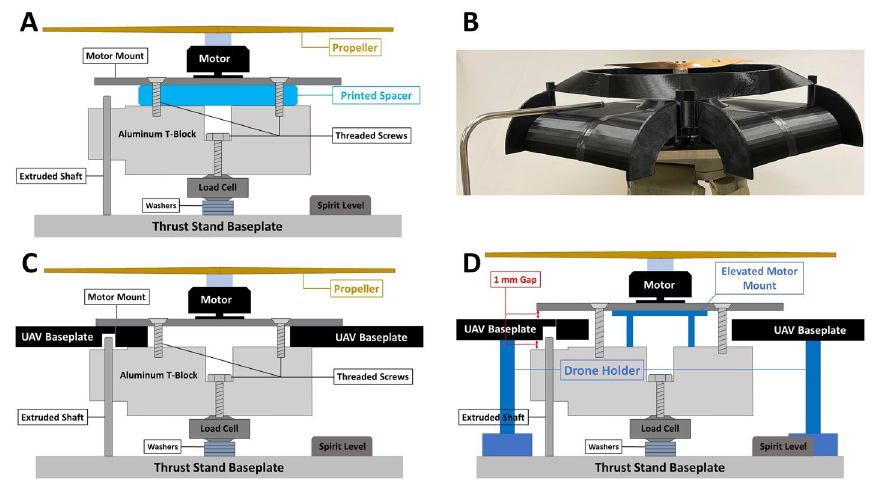
Fig. 4 A Cross-sectional schematic diagram of loading condition 1, B experimental setup for the loading condition 3, C cross-sectional schematic diagram of loading condition 3, D cross-sectional schematic diagram of loading condition